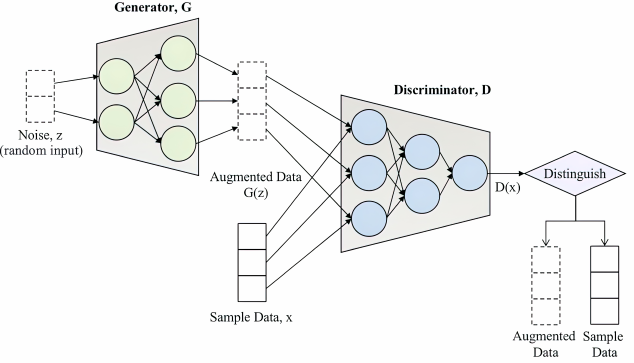
Figure 1. Traditional adversarial transfer network